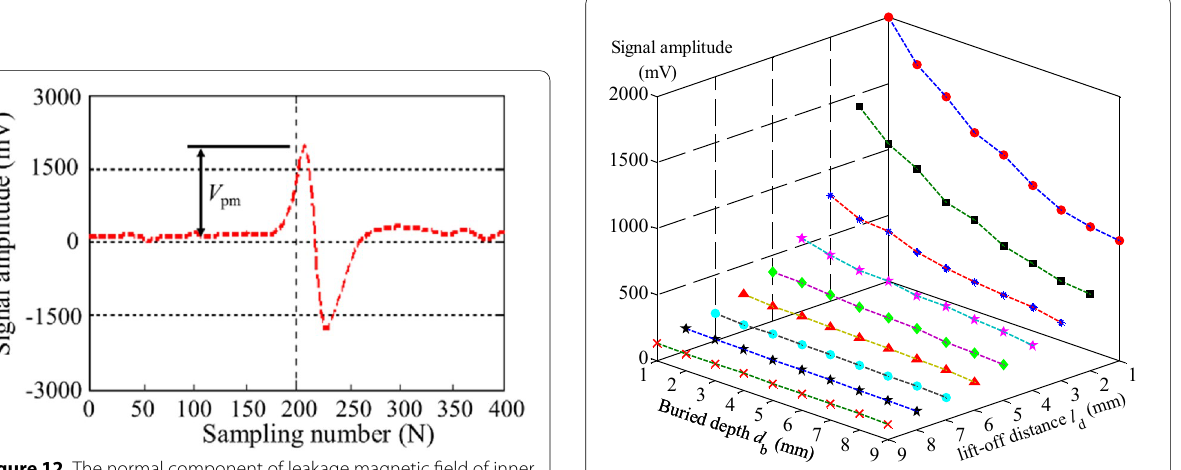
Figure 14 The V pm of the nine inner defects at the same lift-off distance of l d from the sensor to the specimen